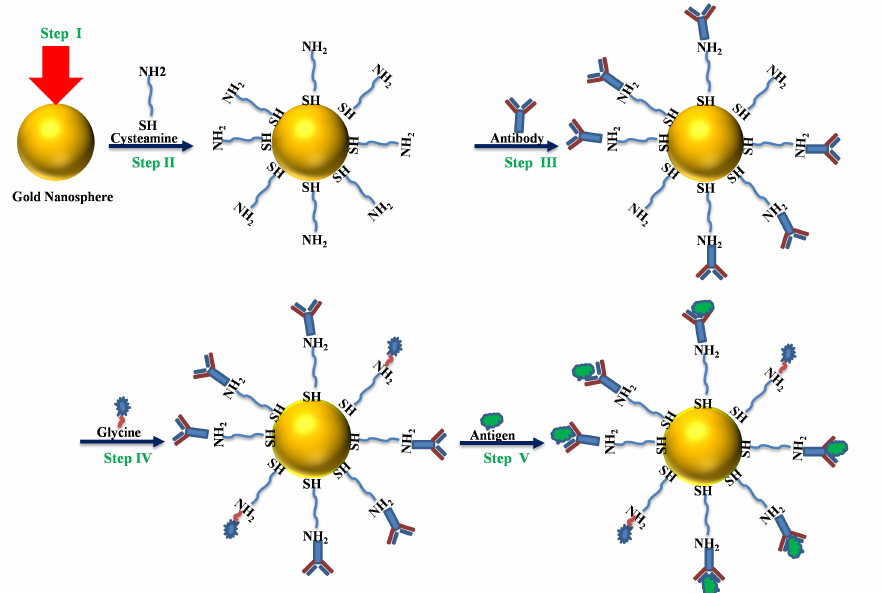
Figure 2. Schematic diagram of the label-free LSPR nanosensor: (step I) colloid Au NPs, (step II) ligand, (step III) anti-NS1 antibody, (step IV) glycine and (step V) adsorbed dengue NS1